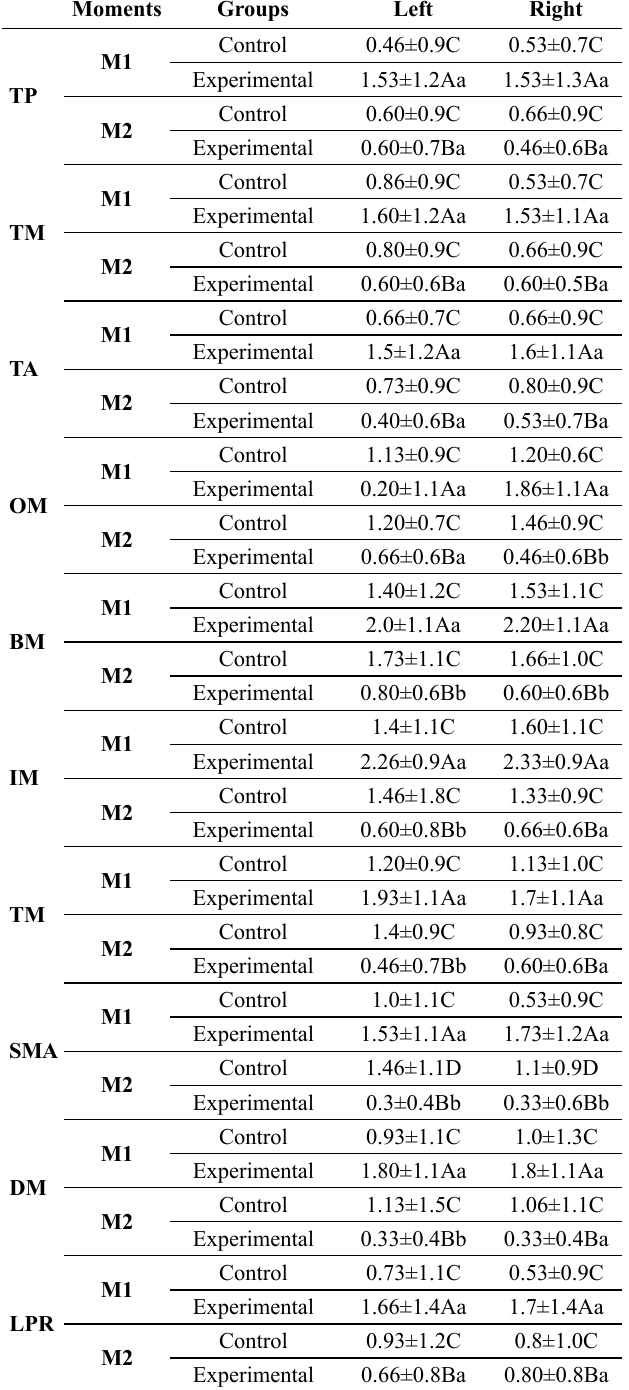
Table 1. Descriptive values for assessment of pain intensity in tempora- lis, masseter, trapezius, the submandibular area, digastric, and the later- al pole of the TMJ in the respective groups and the assessed moments.